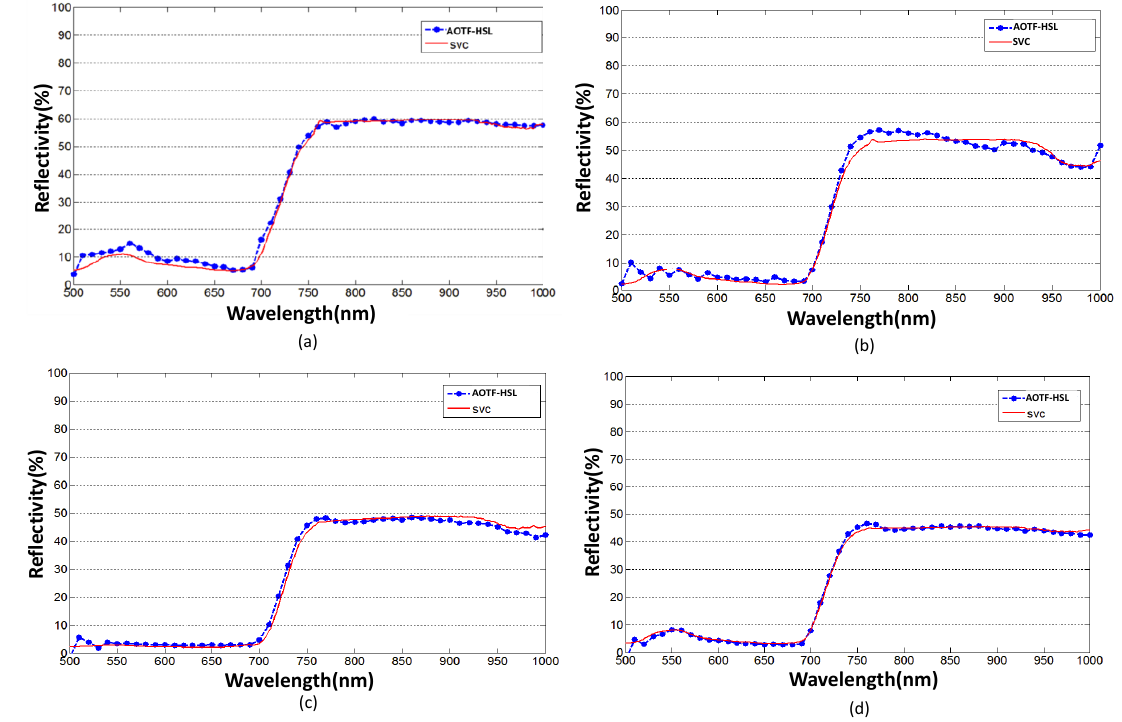
Figure 8. HSL derived spectral profile of green leaves from ( a ) dracaena ( b ) aloe, ( c ) balata ( d ) radermachera compared with spectrometer measurements.